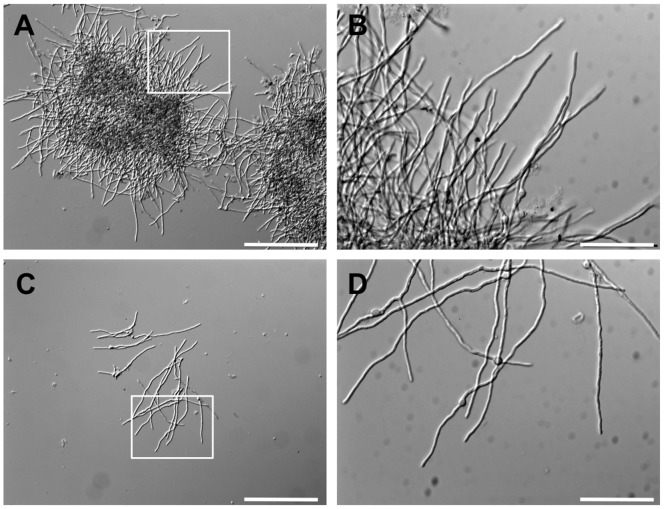
Hyphal morphology of the control and agsB disruption strains grown in CD liquid medium for 12 h at 37°C.(A) Hyphal pellets of the control strain, showing hyphal aggregation (dark areas). Scale bar = 200 µm. (B) Hyphal tip morphology of the control strain. High magnification of the hyphal image in the white frame in panel A. Scale bar = 50 µm. (C) Dispersed hyphae of the agsB disruption strain (DagsB). Scale bar = 200 µm. (D) Hyphal tip morphology of the DagsB strain. High magnification of the hyphal image in the white frame in panel A. Scale bar = 50 µm.